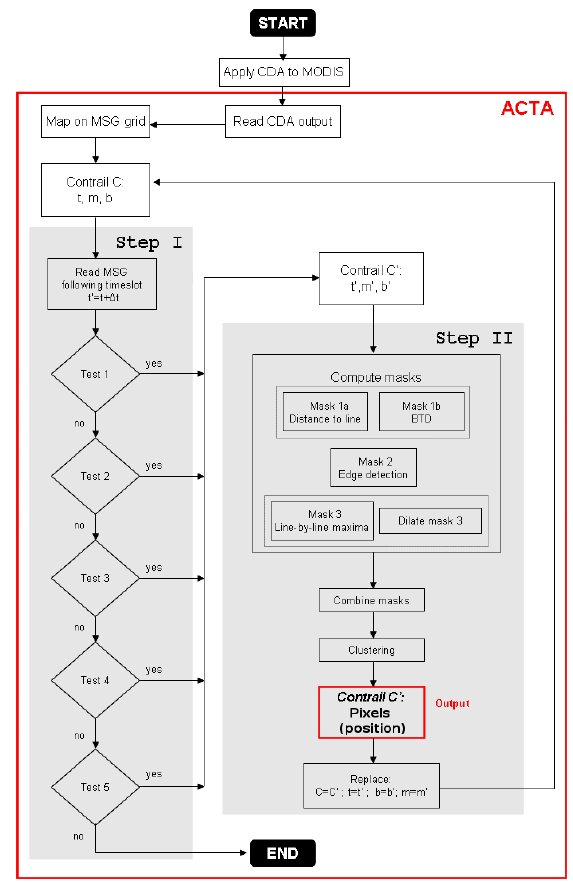
Fig. 3. Schematic overview of ACTA. Input for Step I is the MODIS detected contrail at t . After Step I, m and b , the coordinates of a y = mx + b line are used as input for Step II. Output of Step II are the pixels that belong to the contrail at t + ∆ t .